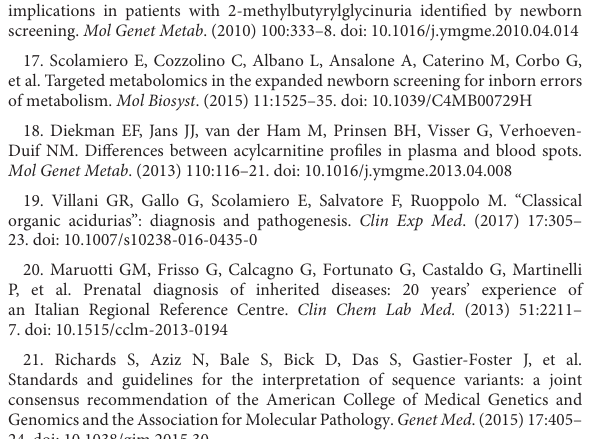
SUPPLEMENTARYFIGURE2 Individual serum free carnitine (C0, black circles, top section of the graph) and 2-methylbutyryl carnitine (C5, gray squares, bottom section of the graph) values in SBCADD patients. For each subject the first time point shows the serum C5 and C0 values detected before starting the L-carnitine treatment. Subsequent time points show serum C5 value after starting with L-carnitine treatment, unless stated otherwise. C0 reference range (10–45 µ mol/L) is shown (dashed lines). # Samples collected after carnitine